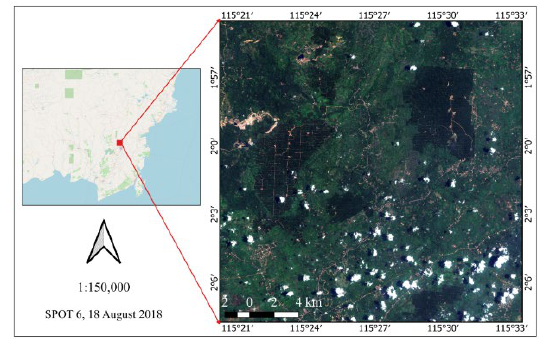
Figure 1. Study area in South Kalimantan